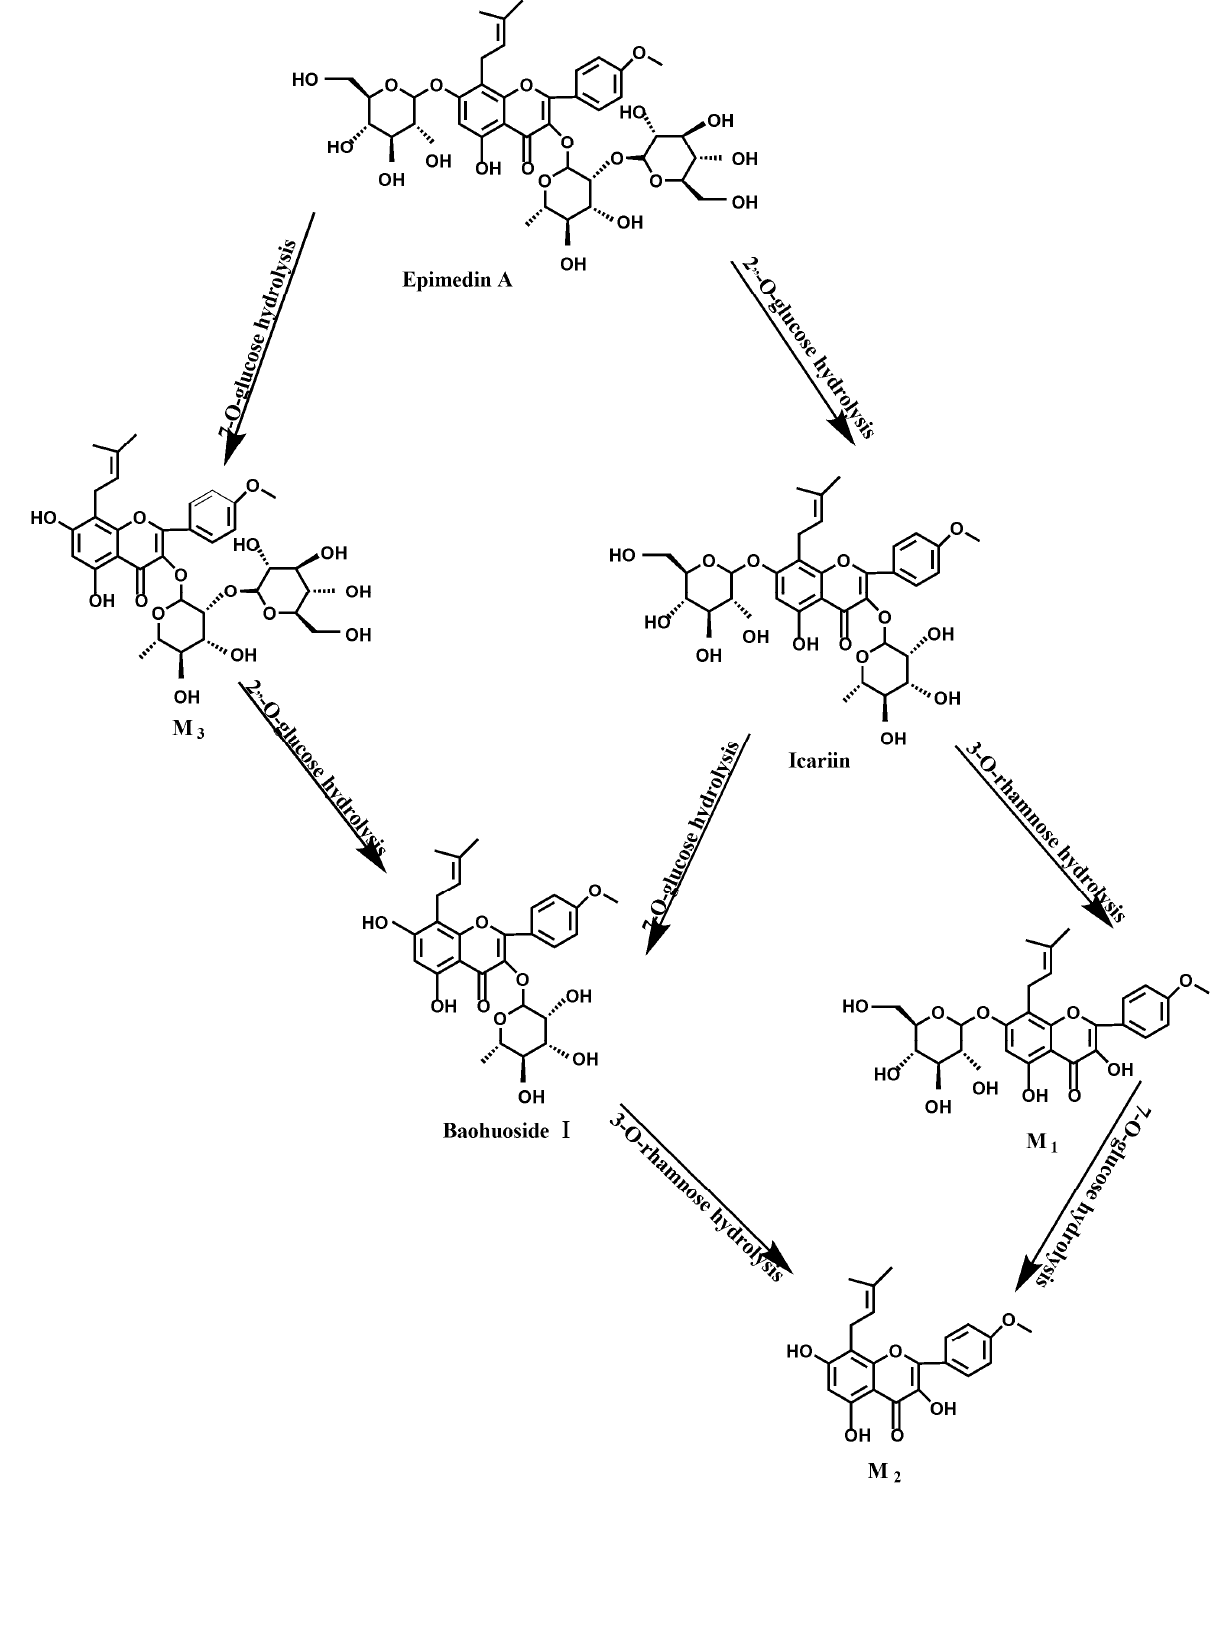
Figure 12. The metabolic pathway of epimedin A in intestinal flora and enzyme of